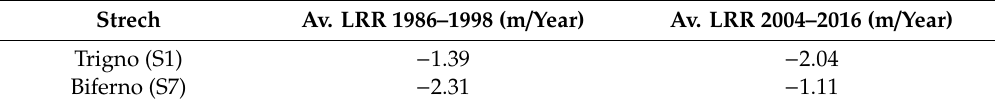
Table 3. Average LRRs at the Trigno and Biferno river mouths.